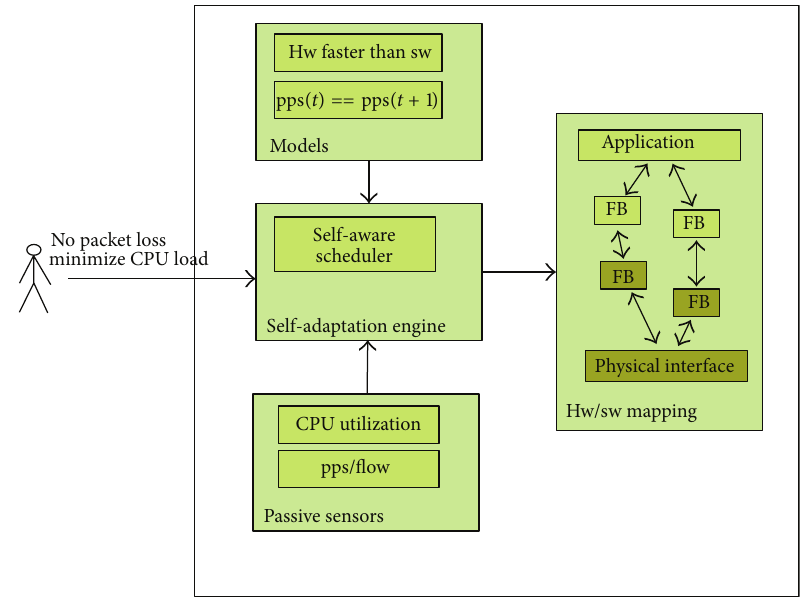
Figure 3: Self-aware hardware/software